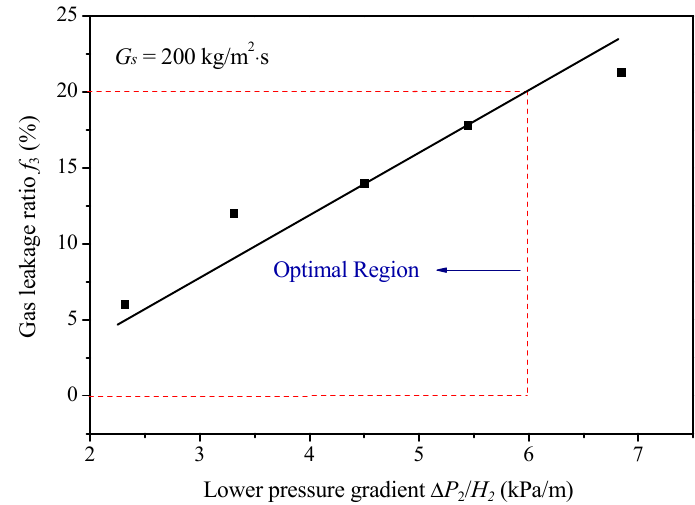
Figure 9. Variations of the J-valve leakage ratio with the lower pressure gradient.